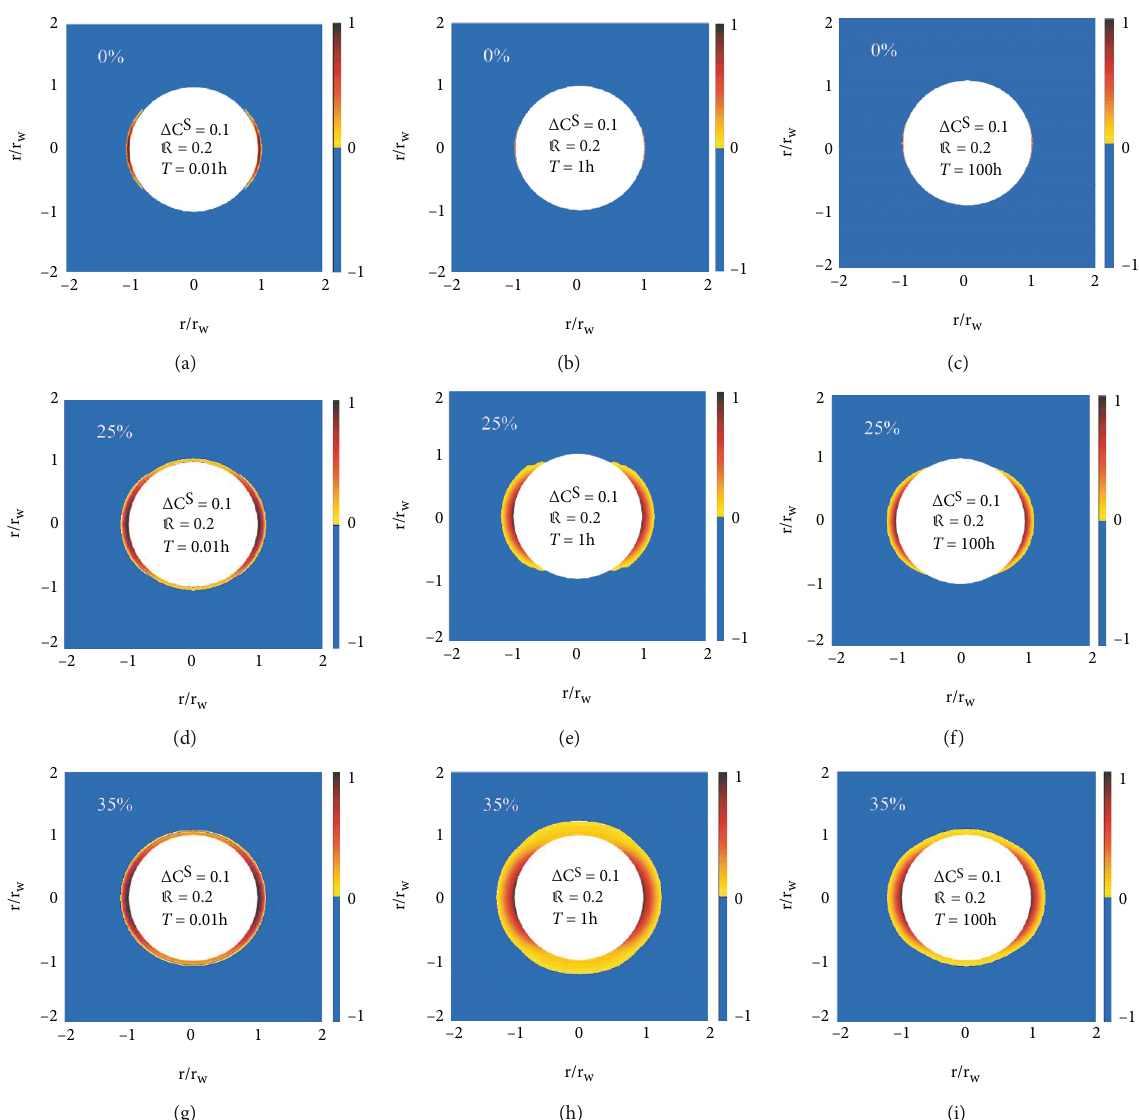
Figure 20: Damage zone around the wellbore (a) 0.01h, (b) 1 h, and (c) 100h after drilling for strength degradation of 0%; (d – f) for strength degradation of 25%; and (g – i) strength degradation of